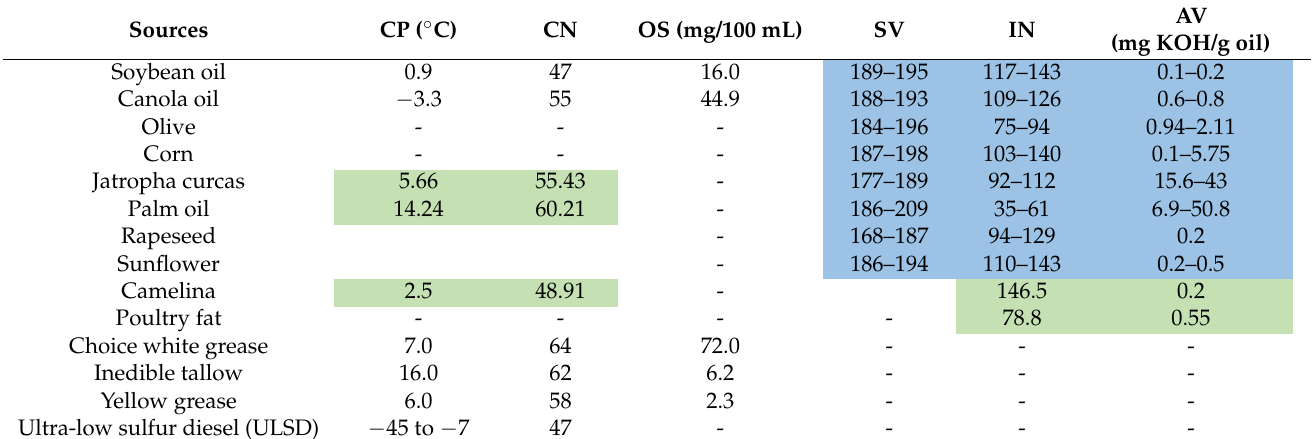
Table 5. Physicochemical properties of different biofuel